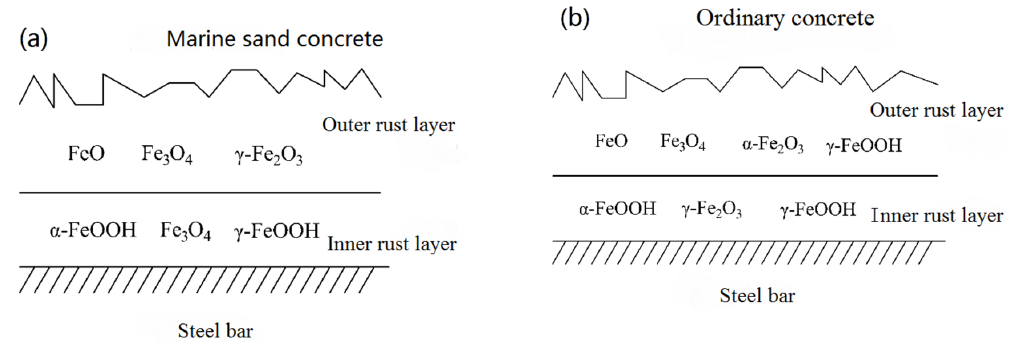
Figure 7. Schematic illustration of layered structure of rebar rust in different concrete; ( a ) Seawater and sea-sand concrete, ( b ) Ordinary concrete.